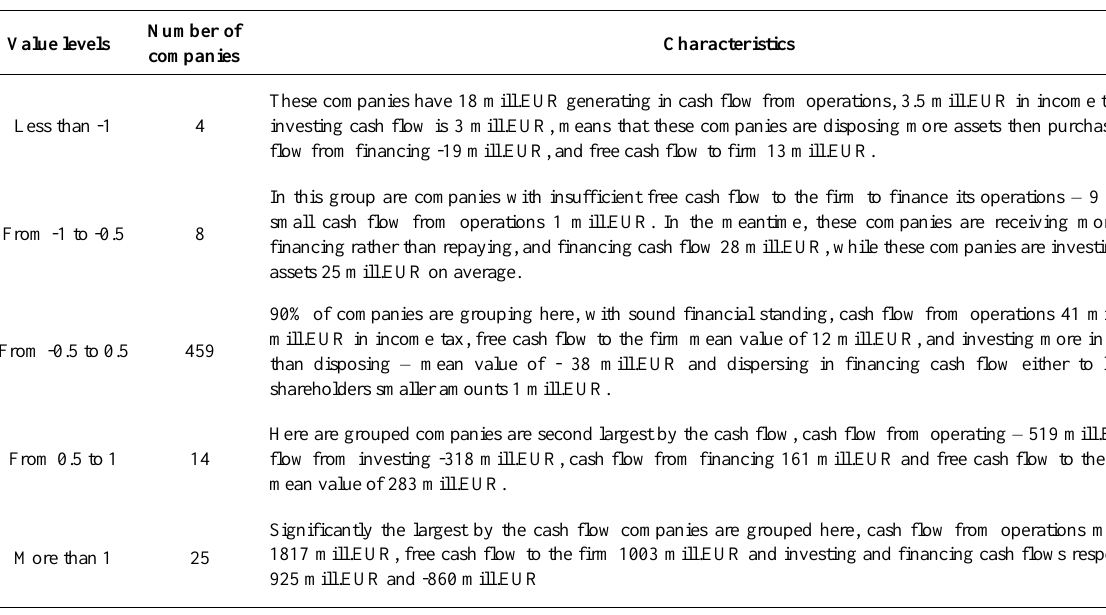
Table 5. Detailed characteristics of Complex factor 2 – cash flow